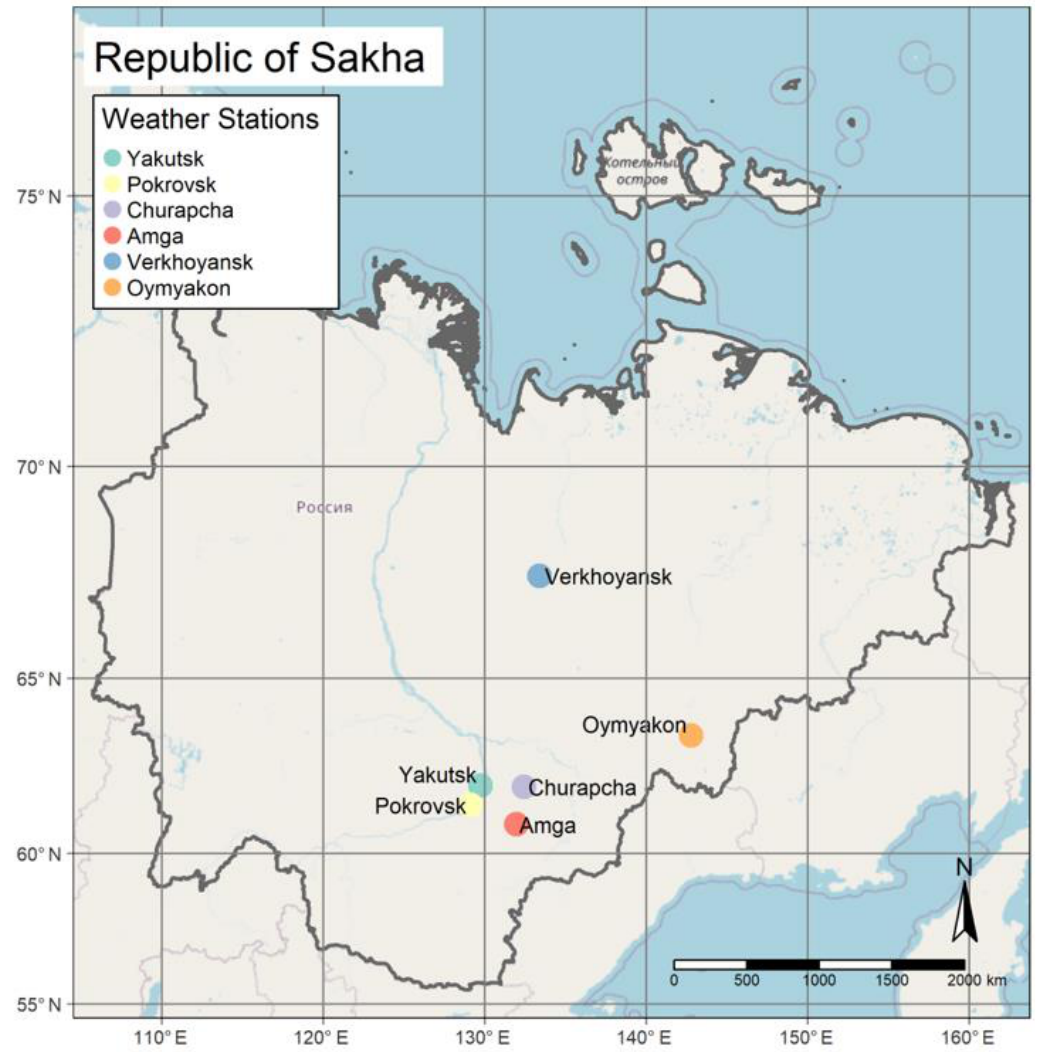
Figure 1. Map of the study area, Republic of Sakha in the Russian Federation. Filled circles indicate locations of the weather stations from which meteorological data was obtained.